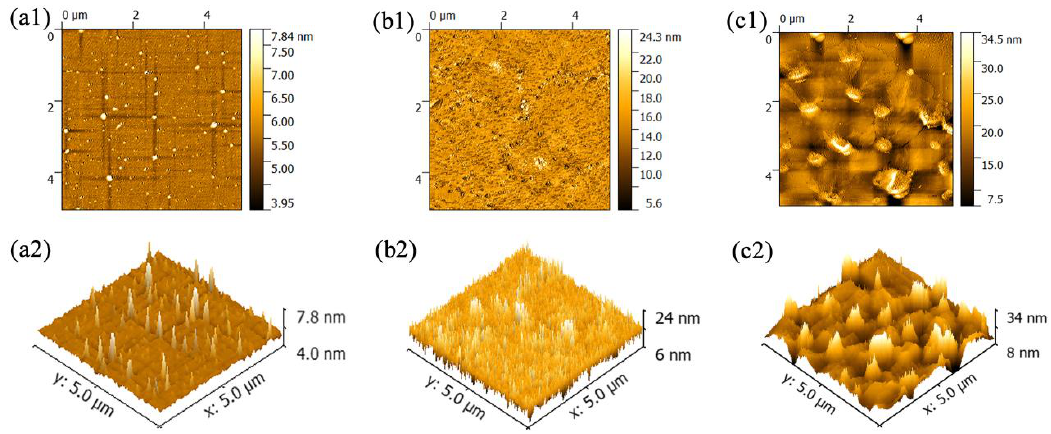
Figure 3. ( a1 , a2 ) AFM 2D and 3D image of PANI, ( b1 , b2 ) AFM 2D and 3D image of the PMoA/PANI hybridizing thin film before optical-light illumination, ( c1 , c2 ) AFM 2D and 3D image of the PMoA/PANI hybridizing thin film after optical-light illumination.